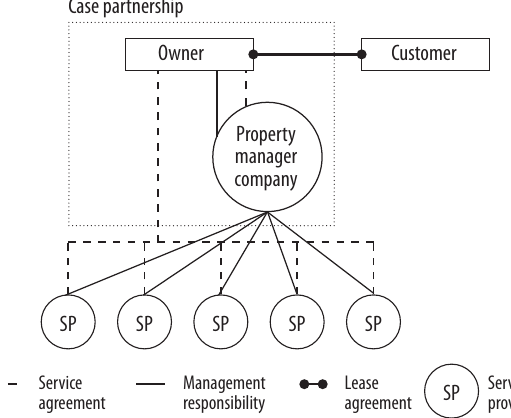
Fig. 1. The contractual relationships in the case partnership